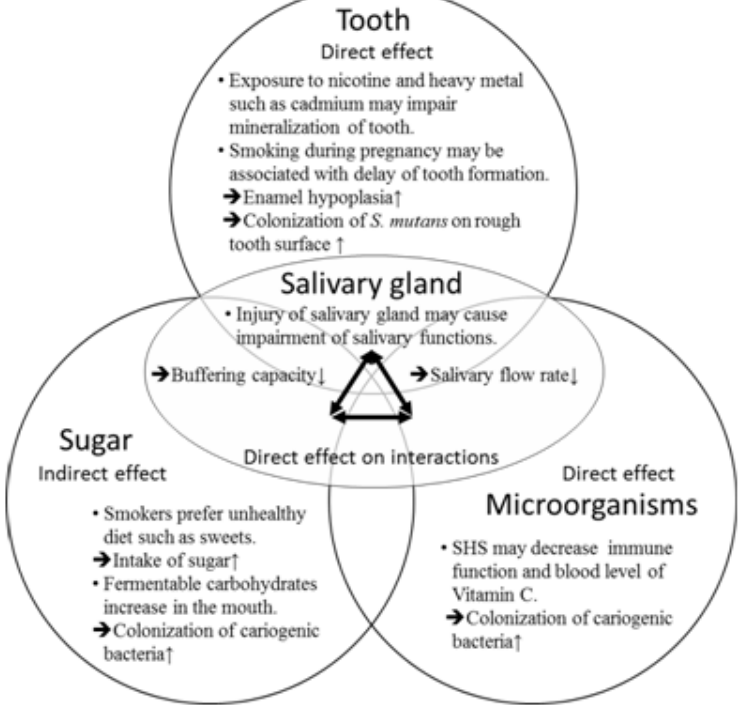
Figure 2. Summary of the biological mechanism of SHS directly or indirectly affecting dental caries in children according to the traditional explanation of the etiology of dental